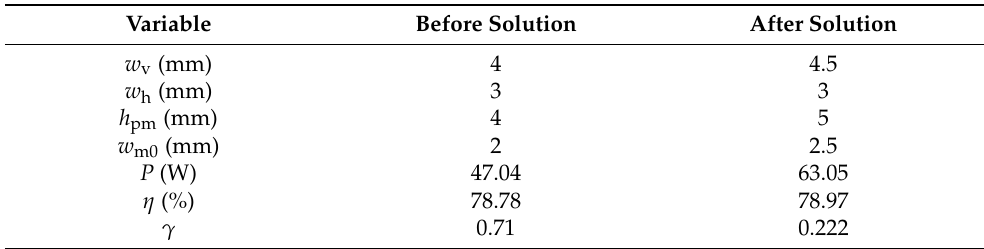
Table 7. Optimization results of design variables and